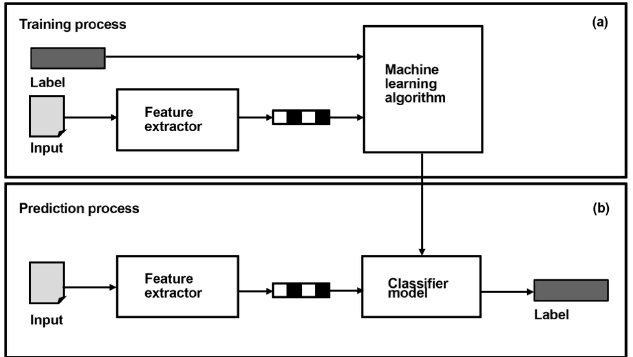
Figure 1. Process of sentiment analysis (SA). Source: Reproduced with permission from Saura and Bennett [2], Symmetry; published by MDPI, 2019.